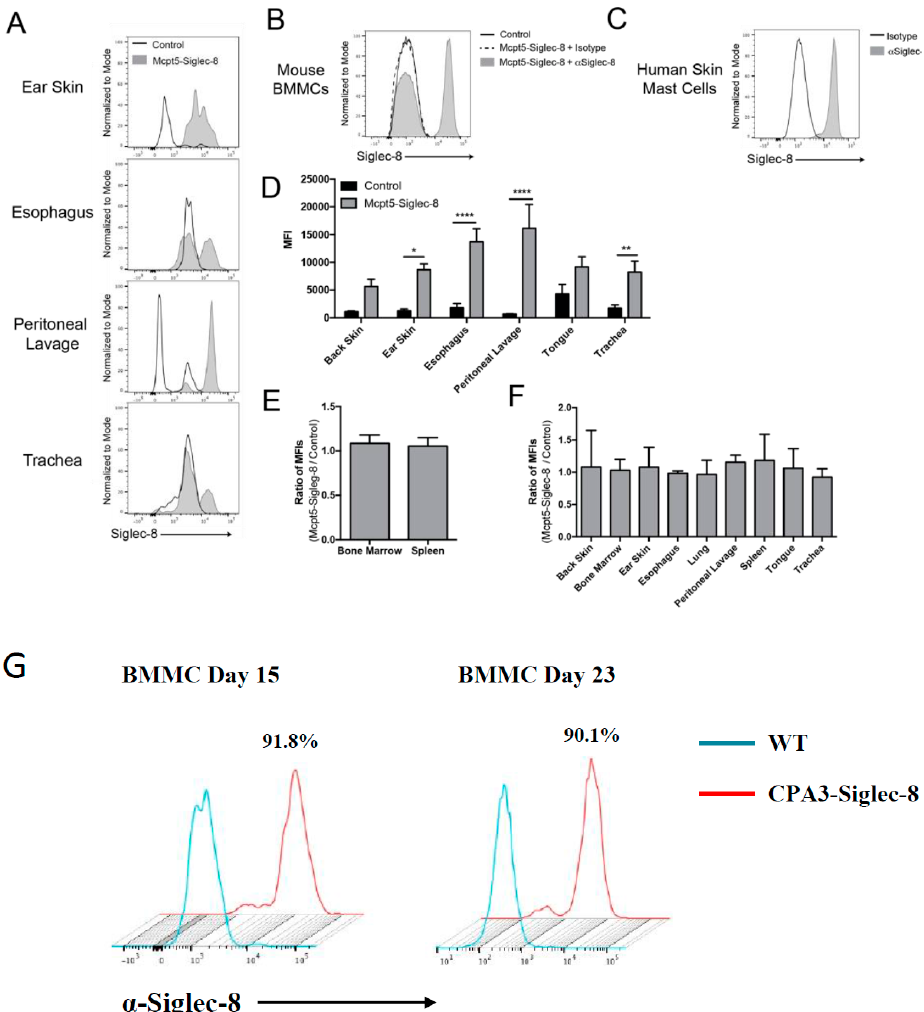
Figure 6. Mast cells selectively express surface Siglec-8 protein in the Mcpt5-Siglec-8 mouse. ( A ) Representative histograms of Siglec-8 expression on mast cells (CD45 + CD11b − Fc ε RI + c-Kit + of live cells) in tissues from Mcpt5-Siglec-8 and control mice. Cells from both mice were stained with anti-Siglec-8 mAb (clone 2E2-AF488) and surface expression of Siglec-8 was assessed by flow cytometry; ( B ) BMMCs from Mcpt5-Siglec-8 and control mice were stained with anti-Siglec-8 mAb or isotype control IgG; ( C ) Human skin-derived mast cells were assessed for surface Siglec-8 expression; ( D ) Quantification of MFI of Siglec-8 staining on mast cells (CD45 + CD11b − Fc ε RI + c-Kit + of live cells) isolated from Mcpt5-Siglec-8 ( n = 3) and control ( n = 4: either WT, n = 1 or Mcpt5-Cre − / − SIG8 +/ − , n = 3) mice. Ratio of Siglec-8 MFI (Mcpt5-Siglec-8/Control) in non-mast cell populations gated for ( E ) eosinophils (live CD45 + Siglec-F mid ), and ( F ) non-immune cells (live CD45 − ); and ( G ) surface expression of Siglec-8 on BMMCs from CPA3-Siglec-8 mice. For panels ( A – F ), shown are data from 3 independent experiments, and the mean ± SEM of n = 3–4 are displayed. Shown in panel G are representative flow cytometry plots of two independent experiments. * p < 0.05, ** p < 0.01, **** p < 0.0001 (two-way